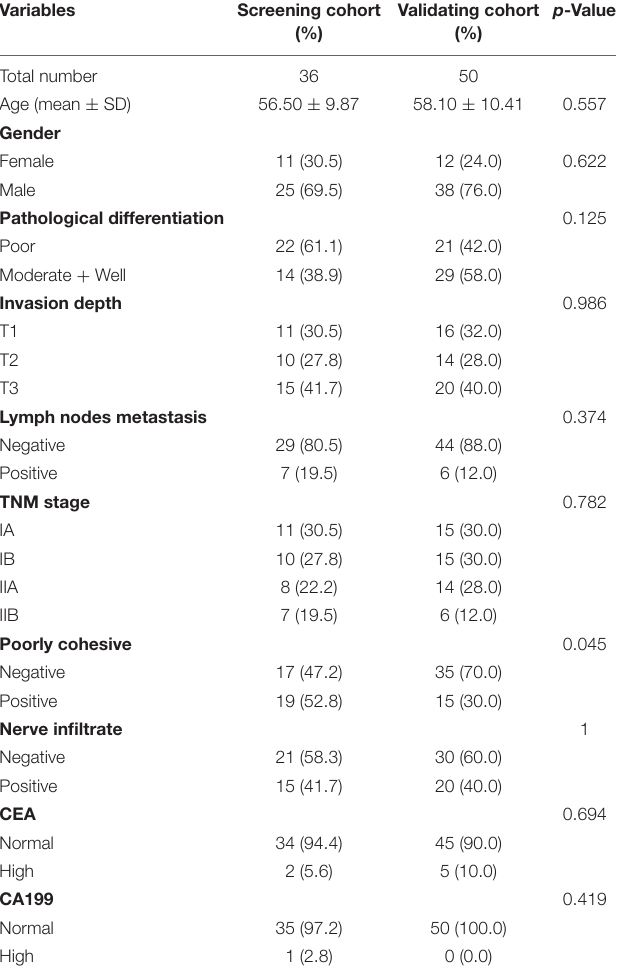
TABLE 1 | Clinicopathological features of early-stage gastric cancer patients in screening and validating